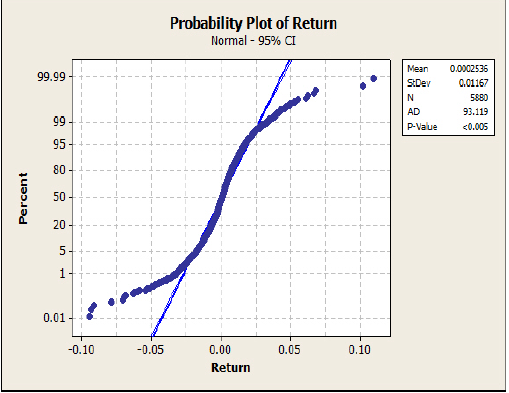
Figure 2. Normal probability